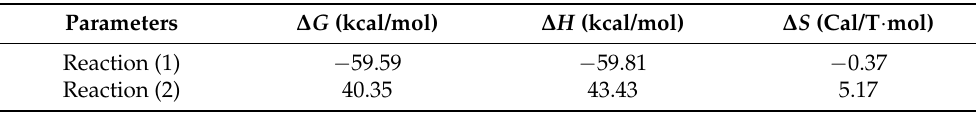
Table 5. Thermodynamic parameters of protonation of L (at standard atmosphere, 298.15 K, in gas phase). Parameters